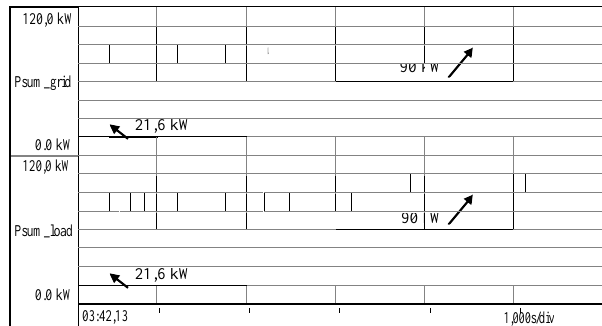
Figure 4. Experiment: transient process without ESS (from top to bottom - the power of the DGU, the load power)